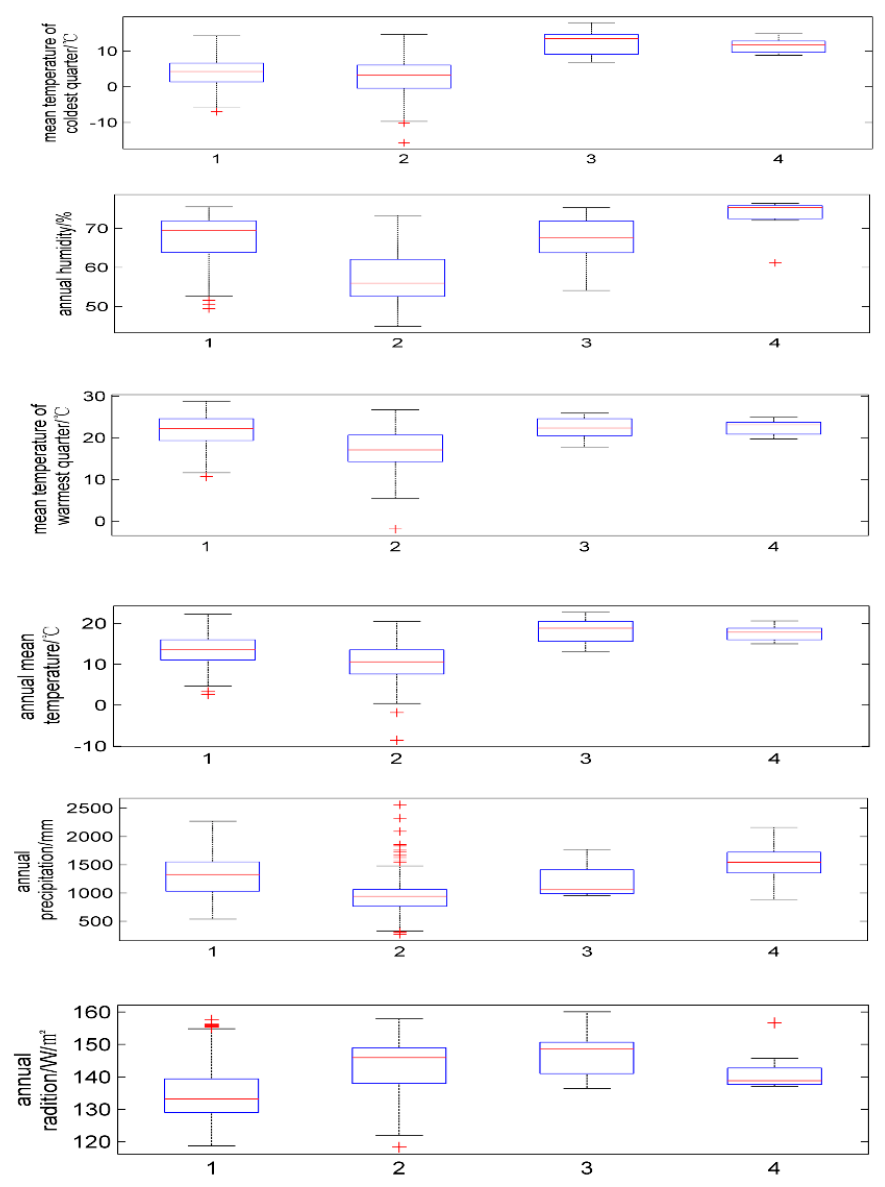
Figure 2. Boxplot of ecological factor of four endangered Panax species by MATLAB, ecological factor scope of P. japonicus and P. japonicus var. major are much broader(1: P. japonicas ; 2: P. japonicus var. major; 3: P. zingiberensis ; 4: P. stipuleanatus ).